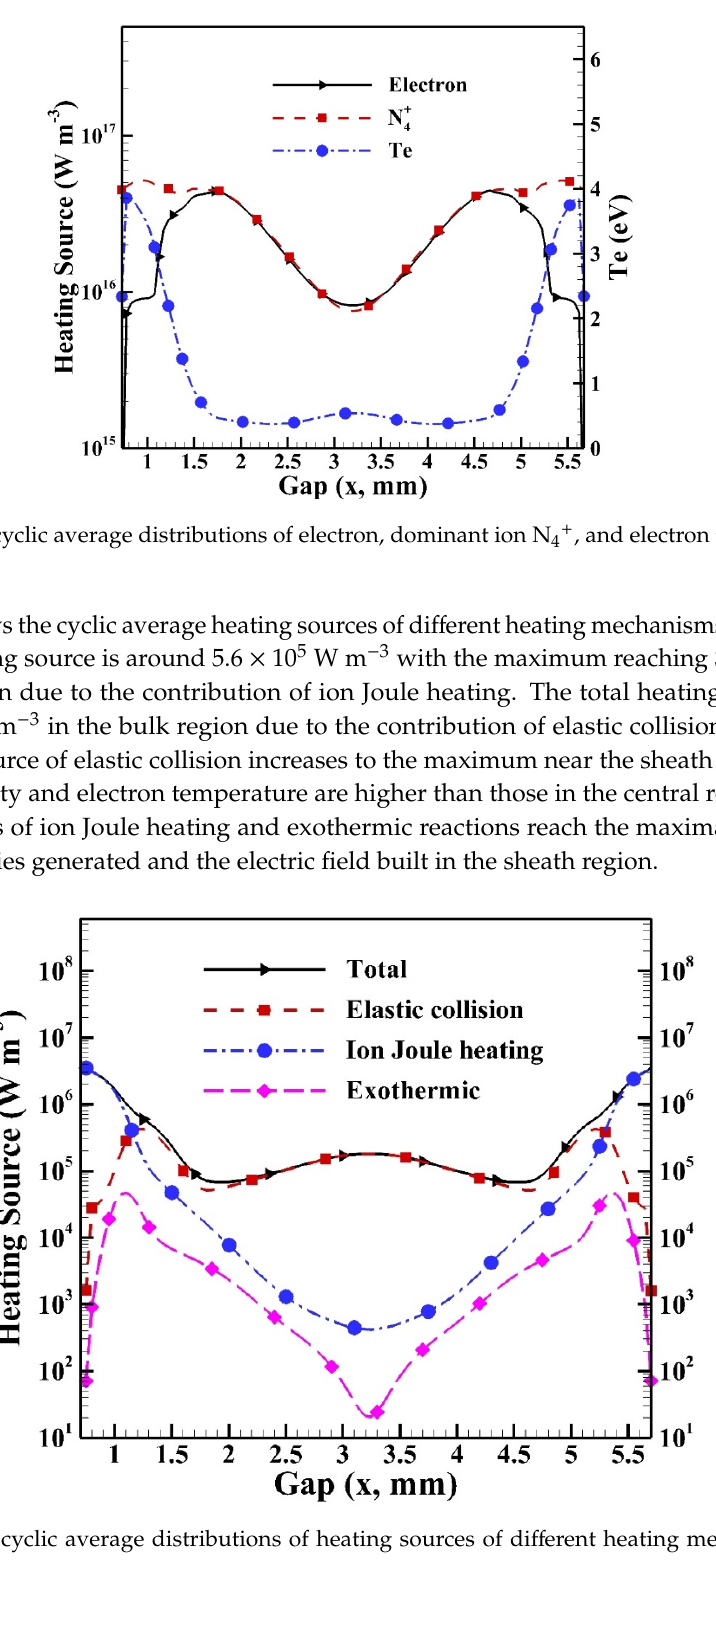
Figure 15. The cyclic average distributions of heating sources of different heating mechanisms in the gap.